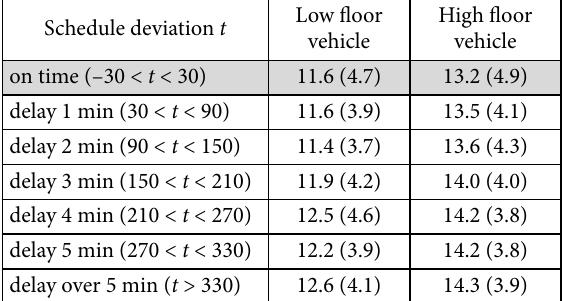
Table 8. Mean value and standard deviation of dwell time [s] at stops according to the floor height and the delays ( source : research by the